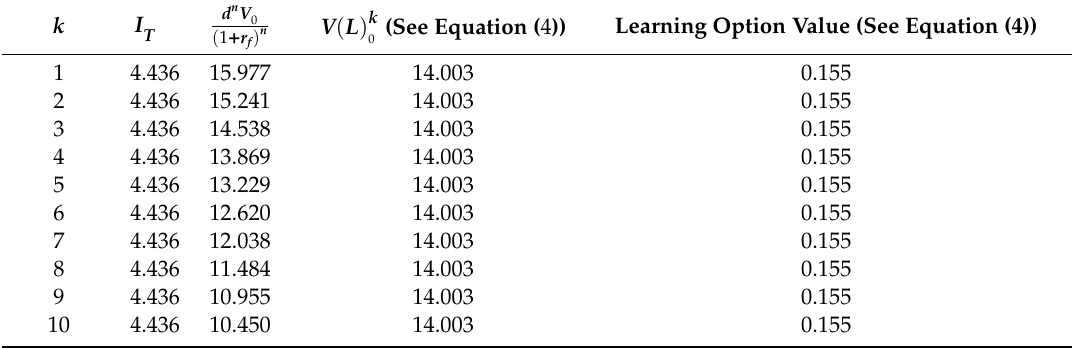
Table A1. Project value (in billion USD) calculated depending on the learning option time horizon (source: own